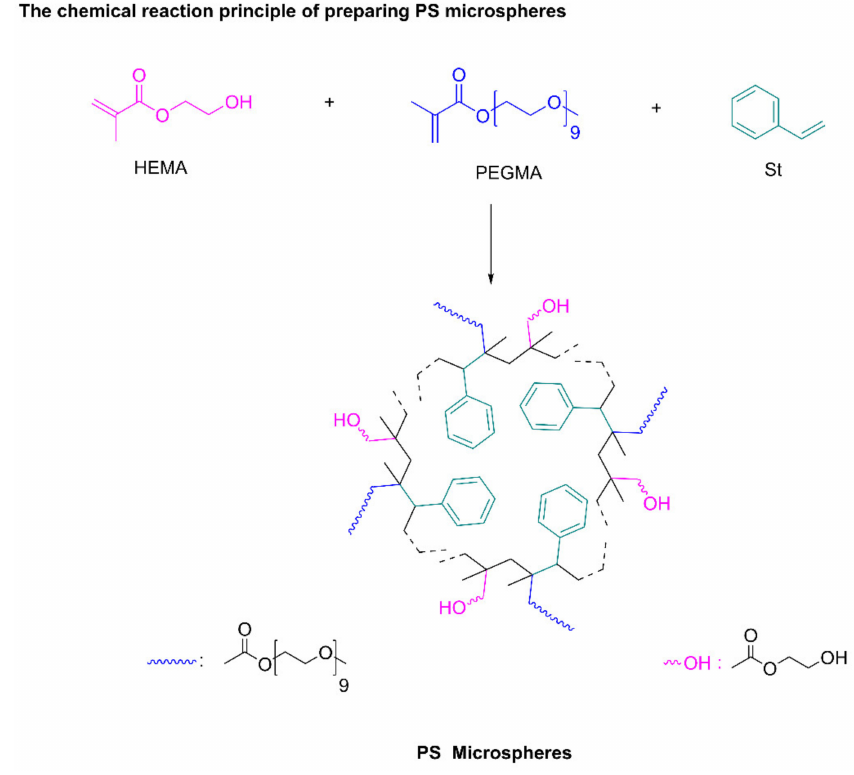
Figure 1. Chemical reaction principle of preparing PS